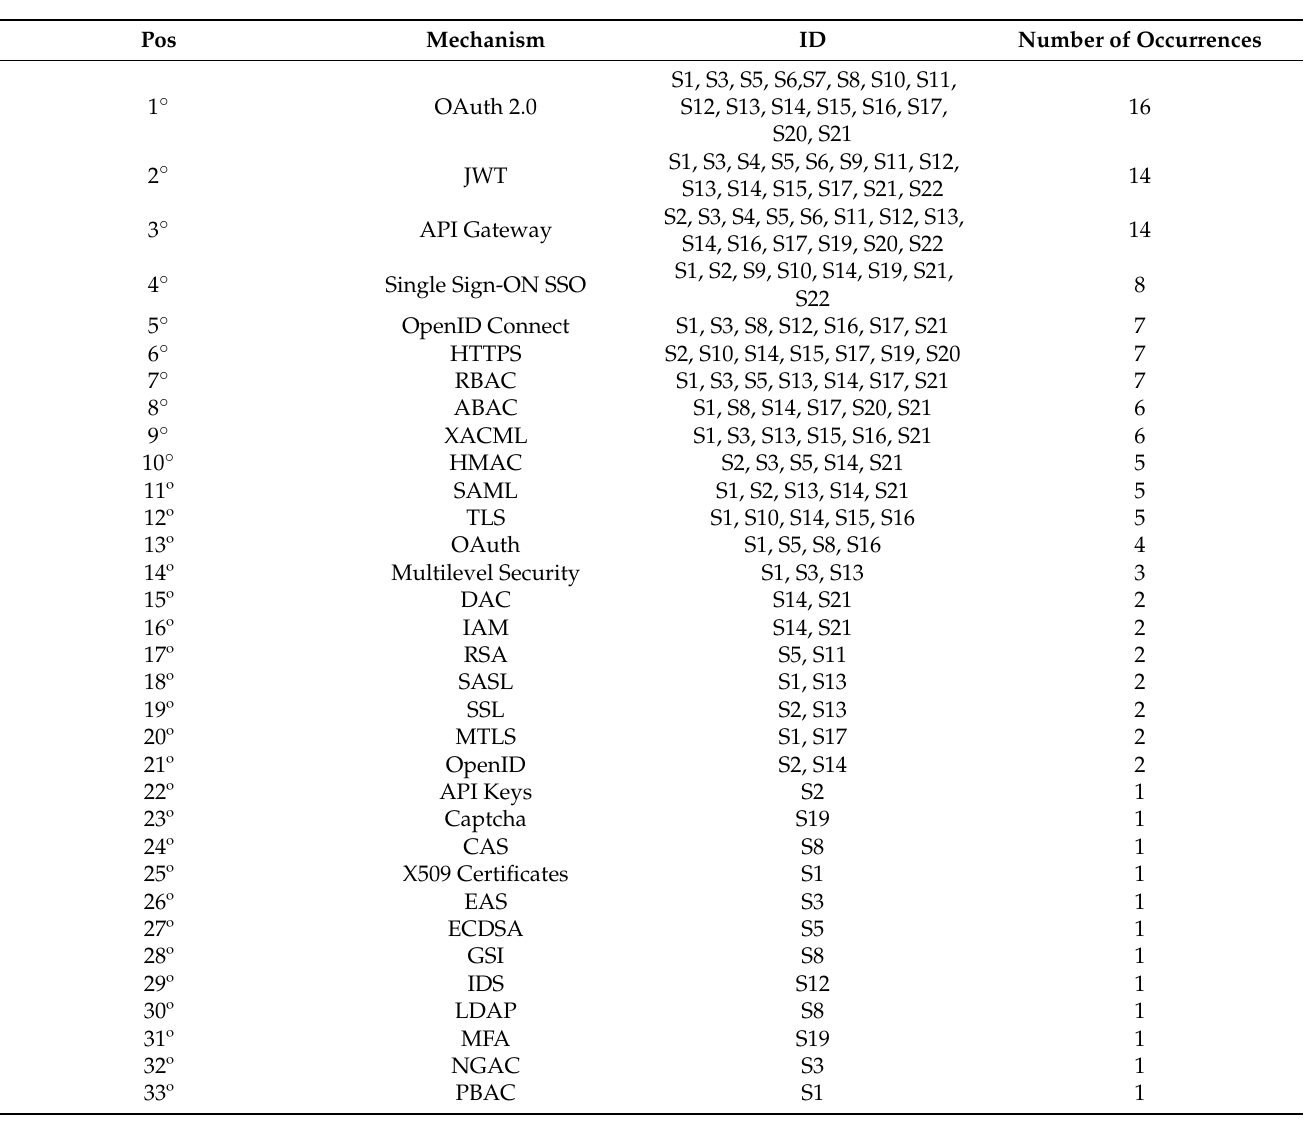
Table 5. Security mechanisms used in microservices